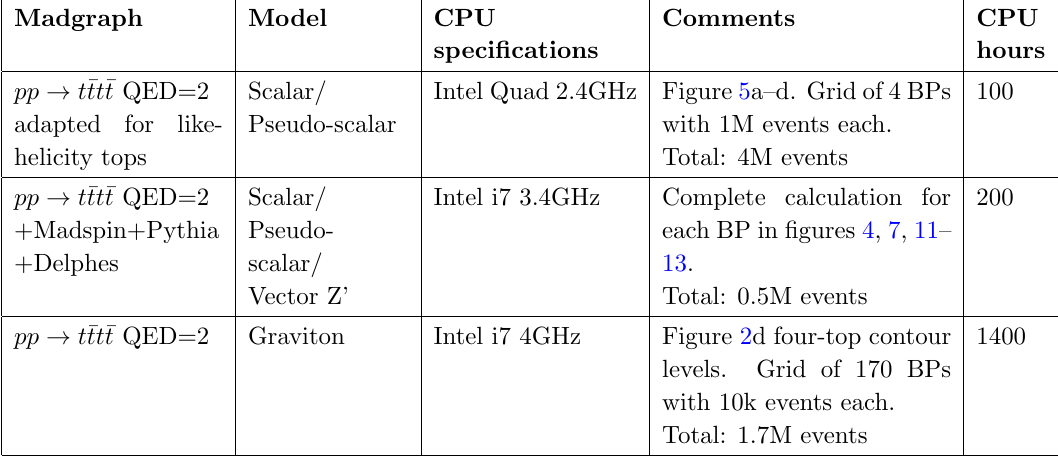
Figure 2d four-top contour levels. Grid of 170 BPs with 10k events each. Total: 1.7M events